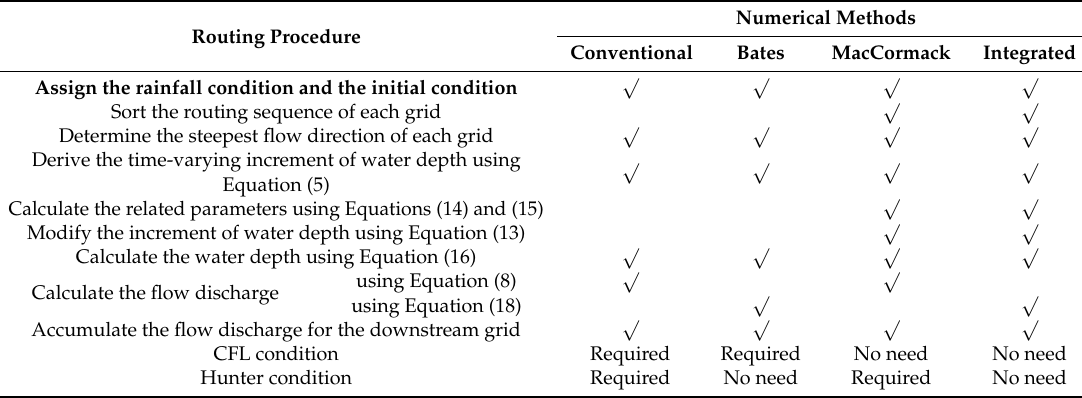
Table 1. Comparison of routing procedures using different numerical